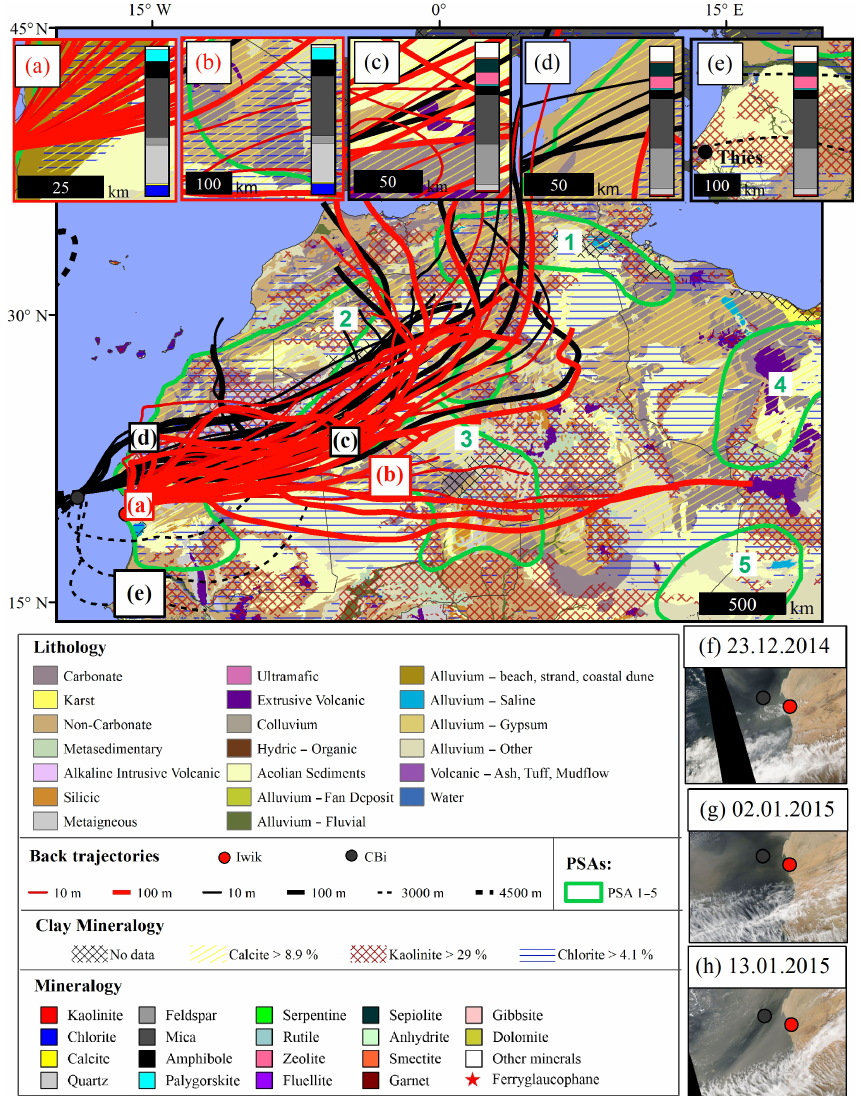
Figure 10. Low-level (10m) 4-day back trajectories of dust events ending during the sampling interval 15 December 2014–18 January 2015 at site Iwik and during the sampling interval 16 December 2014–4 January 2015 at site CBi. The potential source areas and the mineralogy of the samples are given in panels (a–e) . The dust storm events occurring during the sampling interval are indicated in panels (f–h) .